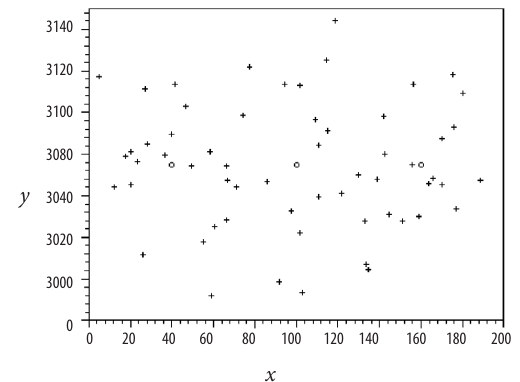
Fig. 6. Scheme of targets when firing at a group target and mine dispersion after 10 salvos. L = 3050 m, σ x = 26 m, σ y = 18 m. ‘ο’ is points of aiming, ‘+’ is points where mines